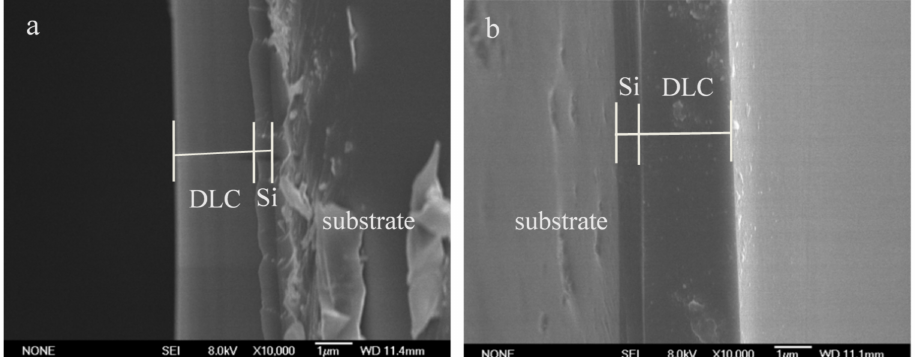
Figure 2. SEM images of fracture cross sections ( a ) G1; and ( b )